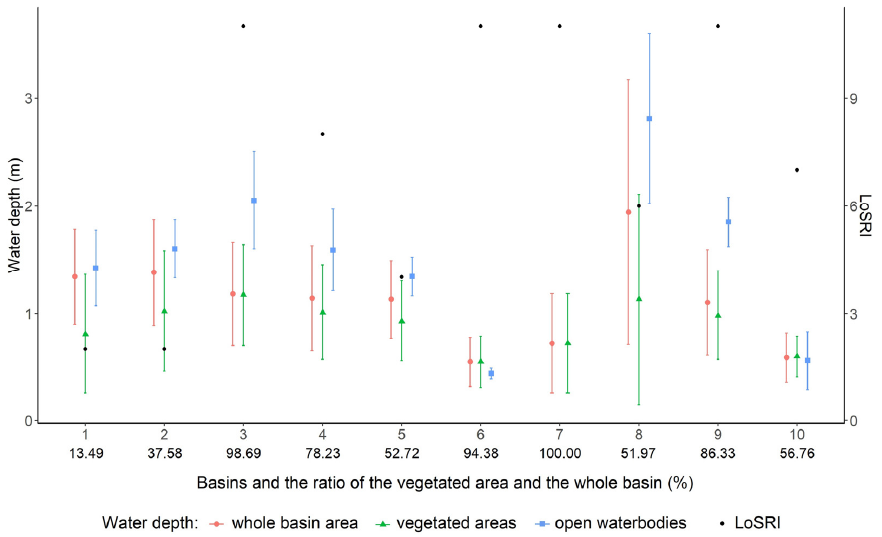
Figure 12. Water depth (left y -axis) and LoSRI (Level of Sedimentation Risk Index) values (right y -axis) for basins ( x -axis; upper numbers) versus ROVW (Ratio Of the Vegetated areas and Water basins) values ( x -axis; lower